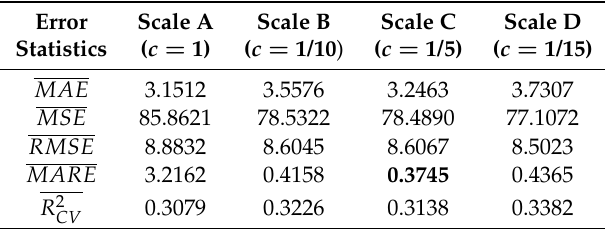
Table 2. Error statistics for the PM 2.5 data set using the shape function-based extension method and 10-fold cross validation before removing outliers.